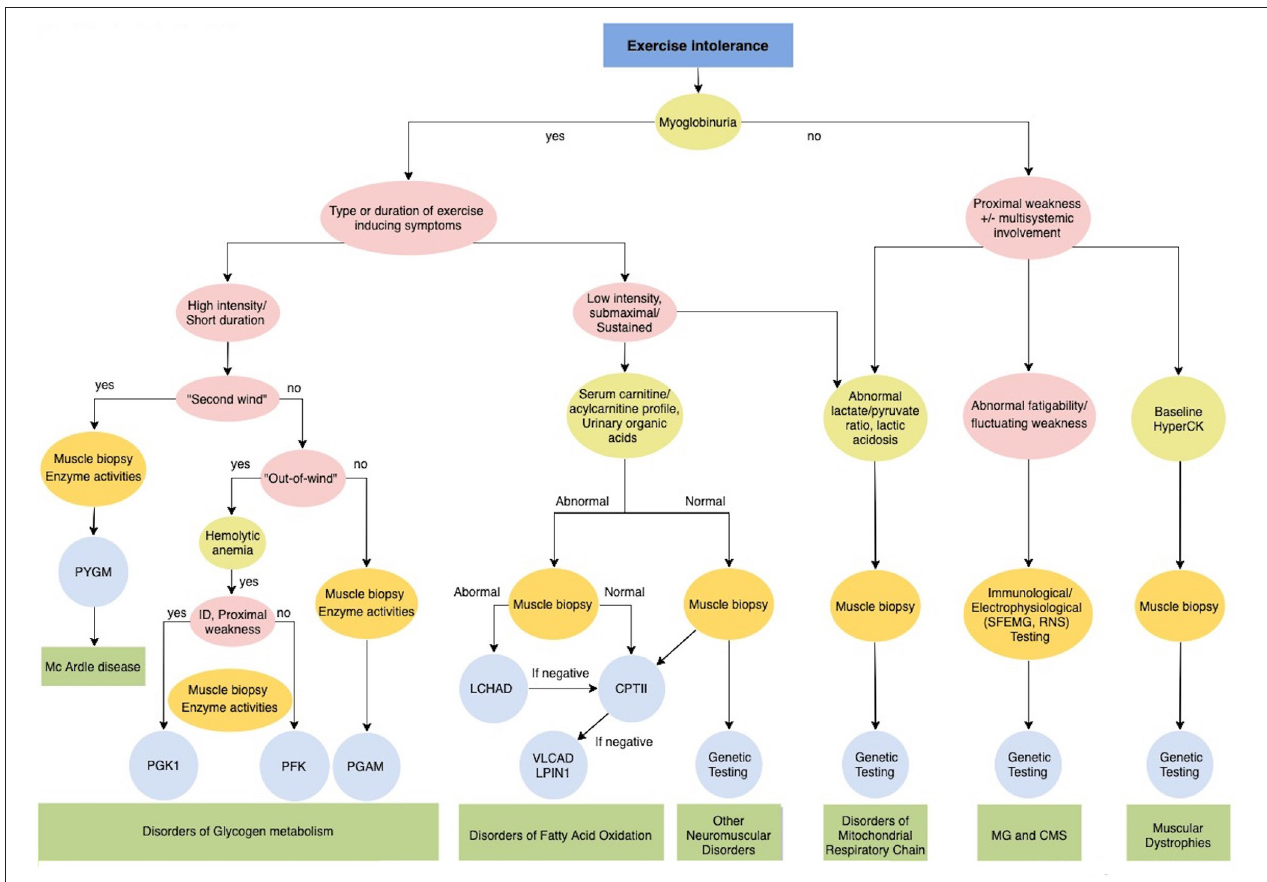
FIGURE 3 | Diagnostic algorithm for Exercise intolerance. CMS, Congenital myasthenic syndromes; CPTII, carnitine palmitoyltransferase II; ID, intellectual disability; LCHAD Long-chain 3-hydroxyacyl-CoA dehydrogenase; LPIN1, Phosphatidate Phosphatase; MG, Myasthenia gravis; PFKM, phosphofructokinase; PGAM, Phosphoglycerate mutase; PGK1, Phosphoglycerate kinase 1; PYGM, phosphorylase; VLCAD, very long-chain long-chain acyl-CoA